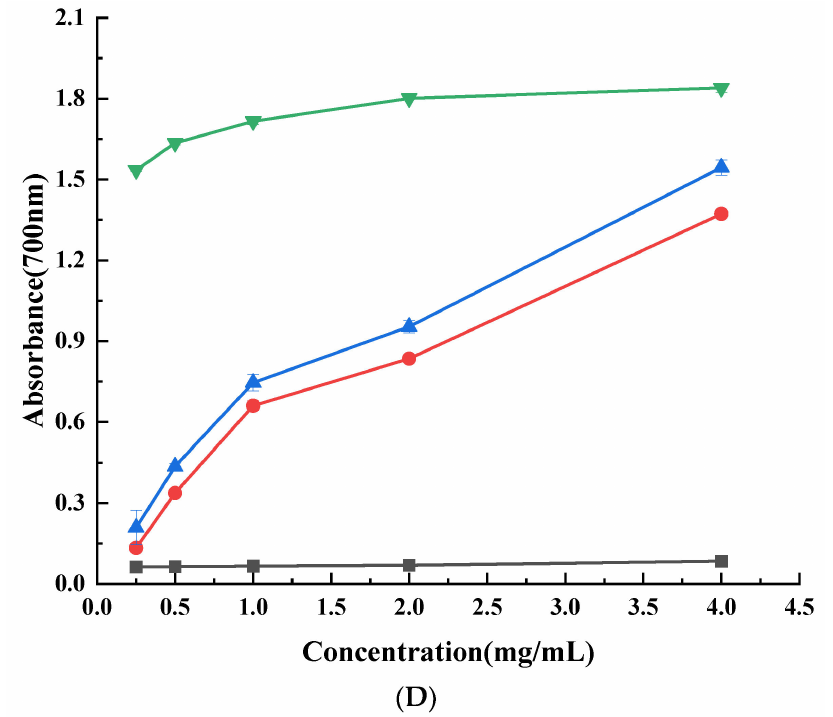
Figure 4. The DPPH radical ( A ), ABTS radical ( B ), hydroxyl radical ( C ), and reducing power ( D ) of CS ( (cid:4) ), CA-g-CS ( • ), CGA-g-CS ( (cid:78) ), and Vc ( (cid:72) ). Data are presented as means ± SD of